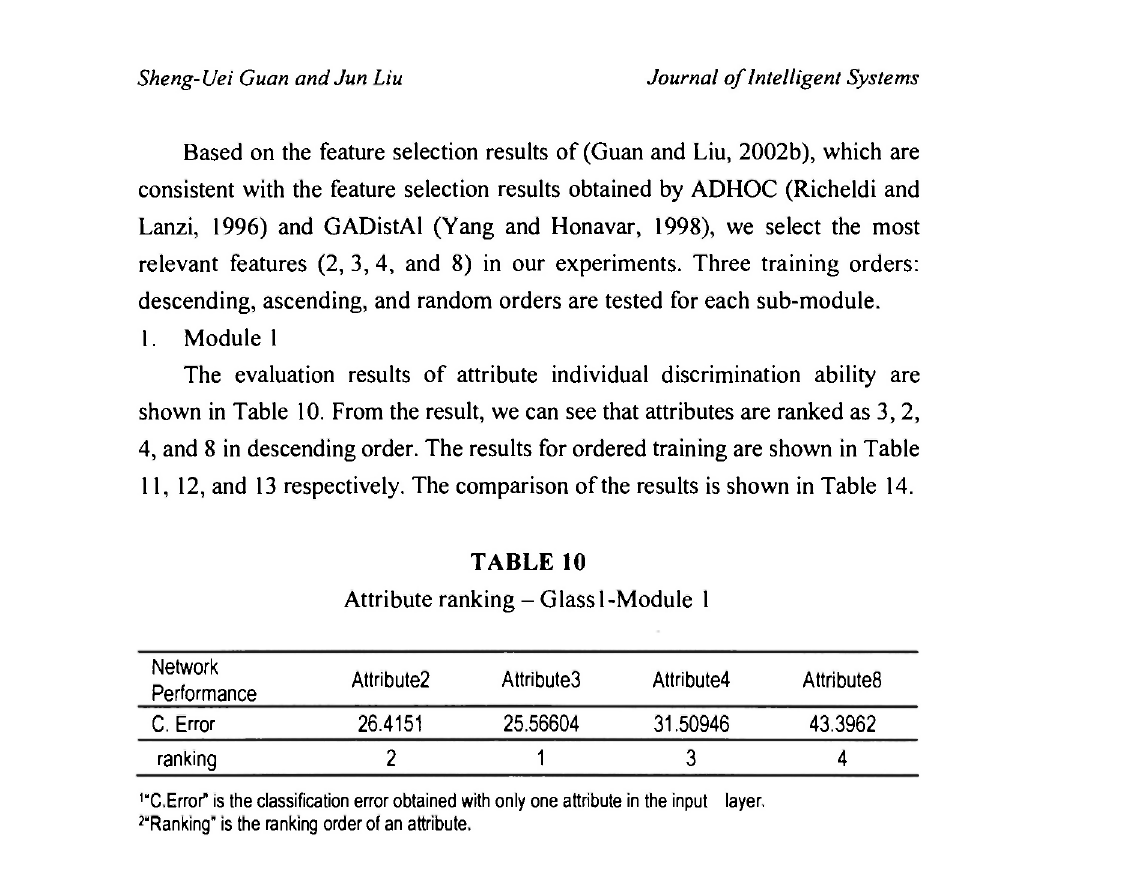
Random-order training - Glass 1-Module